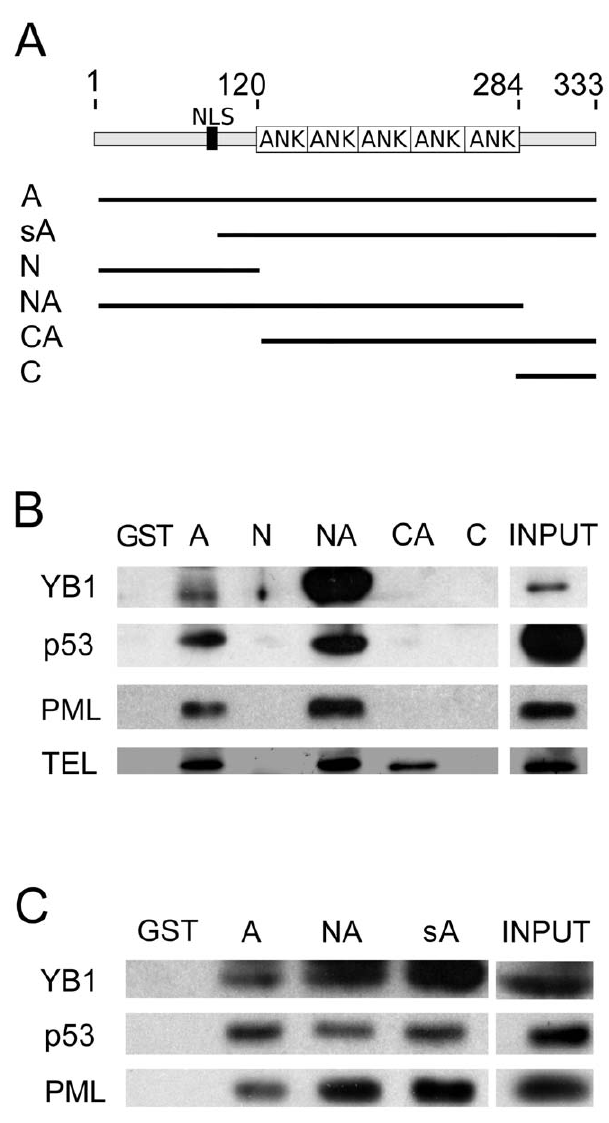
Figure 5. Mapping the interaction sites for YB-1, p53, PML and telethonin/Tcap on Ankrd2. (A) Diagram of Ankrd2 modular structure and deletants used in GST pull-down experiments: A, almost full length Ankrd2 protein (aa 5–333); sA, Ankrd2 protein with a 97 aa N- terminal deletion (aa 98–333); N, N-terminal (aa 5–120); NA, N-terminal plus ankyrin repeats (aa 5–284); CA, C-terminal plus ankyrin repeats (aa 121–333); C, C-terminal (aa 280–333). (B) and (C) GST pull down assays, equal amounts of GST proteins, immobilized on glutathione Sepharose (Figure S2) were mixed with cell extracts containing telethonin/Tcap, YB-1, p53 and PML. The resins were washed, subjected to SDS-PAGE and immunoblotted. Negative control is GST, positive controls (INPUT): for telethonin, 1 m g of U2OS cell lysate; for endogenous p53, 500 ng of COS7 cell lysate; for YB-1 500 ng of lysate of COS7 cell overexpressing FLAG-YB-1; and for PML, 500 ng of lysate of COS7 cells overexpressing FLAG-PML. sis, focal adhesion, tight junction, gap junction and regulation of the actin cytoskeleton) and intracellular communication (calcium, insulin, MAPK, p53, TGF- b and Wnt signaling). Using protein arrays we identified several interacting partners of Ankrd2; PDZ- and SH3-containing proteins and transcription factors. Interest- ingly, the TF proteins MeCP2, Pax6, NFIL3 and LHX2 bind both